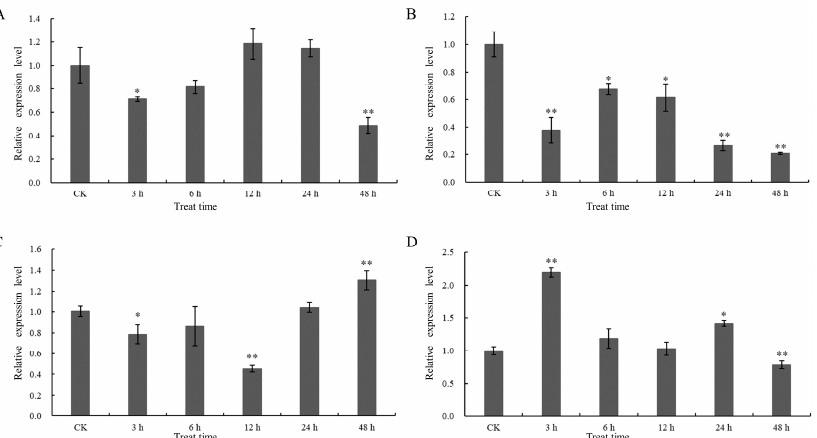
Figure 7. Expression pattern analysis of GhCIPK23 gene under different stress conditions in upland cotton. ( A ) Drought treatment (20% PEG6000); ( B ) salt (200 mM NaCl); ( C ) low-temperature treatment (4 °C); ( D ) exogenous abscisic acid treatment (100 μ M ABA). The error bars represent standard errors of three independent repetitions. * p < 0.05; ** p < 0.01.